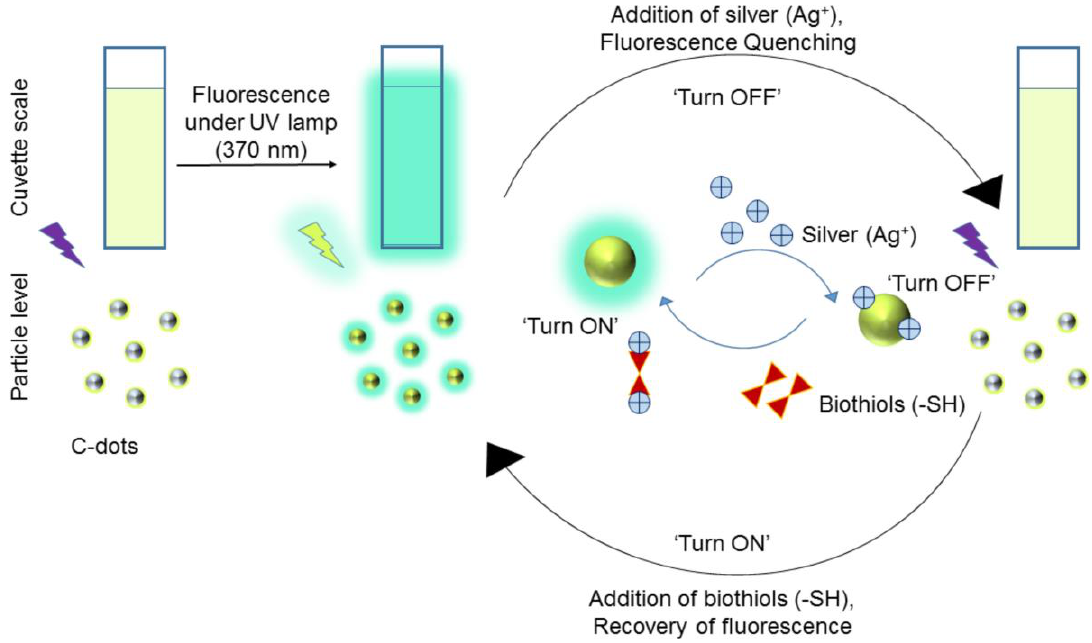
Figure 7. Schematic illustration of the C-dots based ‘turn off-on’ silver-biothiols dual sensing (reproduced with the permission from Ref. [109]).